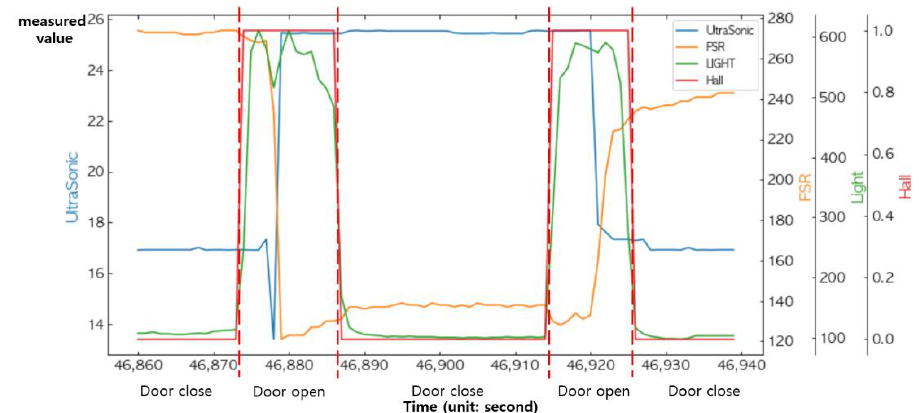
Figure 23. Changes in the sensed values when taking out an item.